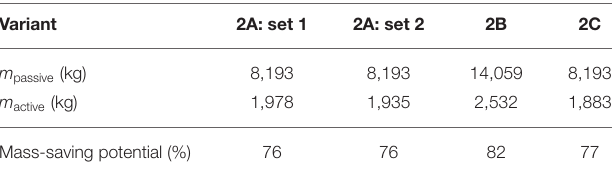
TABLE 2 | Example 2, frame design: total masses and mass-saving potentials (additional actuator mass not